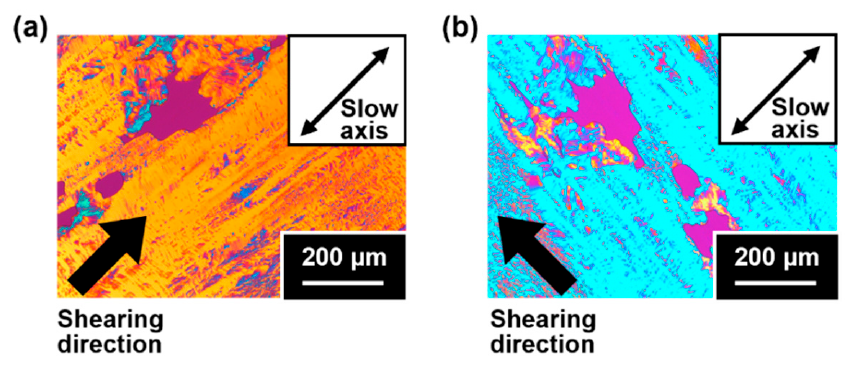
Figure 5. Polarized optical microscopic images of the mixtures of pQpdS-Ch /H 2 O (X = 60) in the Col h phase after shearing. ( a ) The shearing direction is parallel to the slow axis of the retardation plate. ( b ) The shearing direction is perpendicular to the slow axis of the retardation plate. In order to further confirm the molecular assembled structure of the pQpdS- Ch /H 2 O mixtures in the Col h phase, we have performed polarized IR measurements. A 1D-aligned sample of the pQpdS-Ch /H 2 O (X = 70) mixture was prepared by the same method. IR absorbance was measured with setting the angle of the polarizer ( θ p ) in the range from 0 to 180 degrees. The Col h LC sample was set in such a way that its column axis was parallel to θ p = 0 degree. While the S=O stretching vibration ( ν S=O ) of the pQpdS molecules was observed at 1301 cm –1 independent of the θ p angles, the peak strength of ν S=O clearly depended on the θ p angles. For example, the absorbance of ν S=O was 0.20 when θ p = 0 degree, which increases as the increase of θ p (Figure 6a). For further clarify θ p -dependence of the ν S=O absorbance, we have constructed a polar plot (Figure 6b). It indicates that the sulfonyl groups of the pQpdS molecules are oriented perpendicular to the 1D column axis.